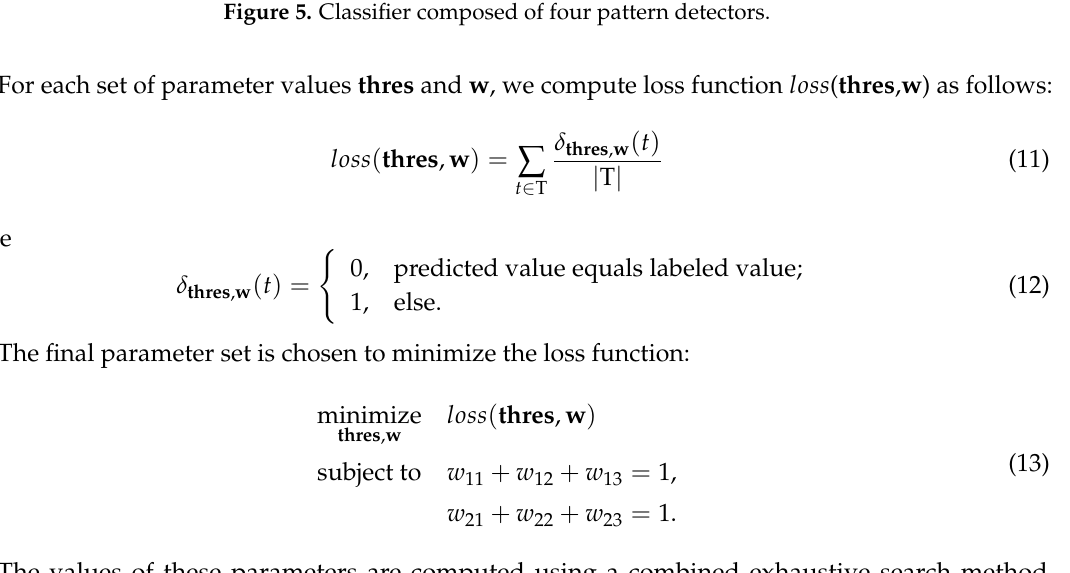
Figure 5. Classifier composed of four pattern